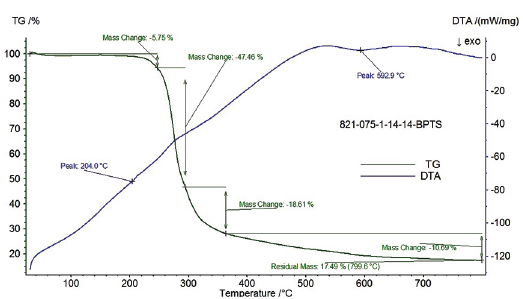
Figure 6: FTIR spectrum of 4BPTS